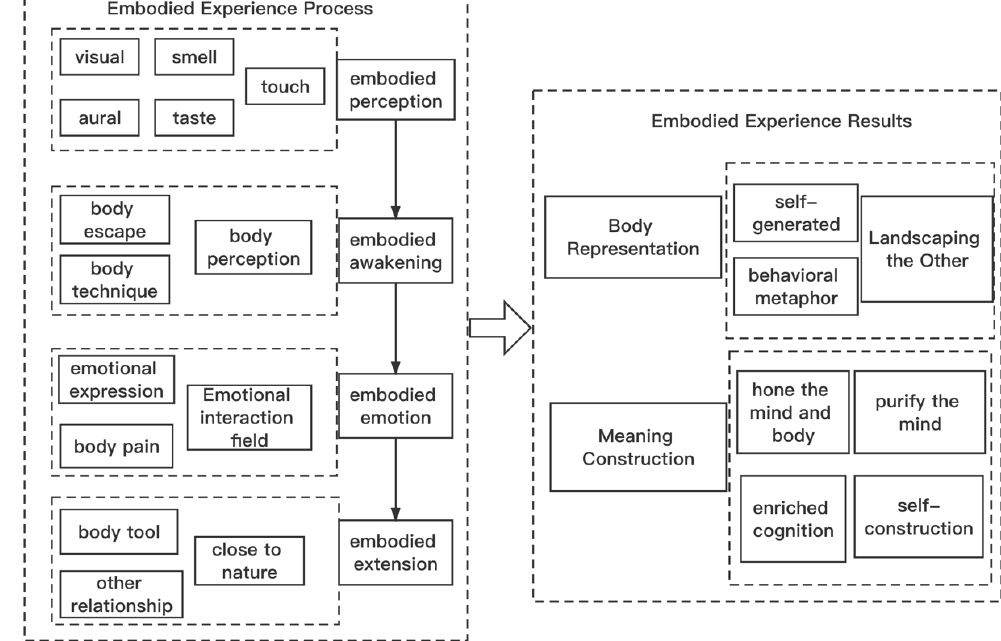
Figure 2. Embodied experience model of surfing tourism behavior.